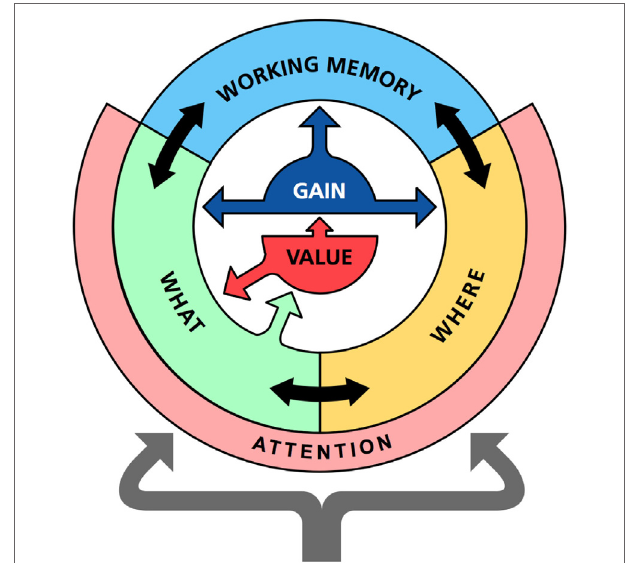
FigUre 1 | Overview of the memory model. The memory model consist of three main parts: the identification network (WHAT), the localization network (WHERE), and a prefrontal working memory network (WORKING MEMORY). Each network is modeled as a recurrent neuronal network with similar design but with slightly different dynamics. In addition to internal recurrent connections, there are also temporal associations that can read out sequences of states in memory. The identification and localization networks also include an attention component that detects novel external stimuli and compares expected to actual inputs to potentially generate surprise signals. The identification network communicates with value system (VALUE). All processing is under the influence of a gain modulation system (GAIN) that controls the randomness of the state transitions in